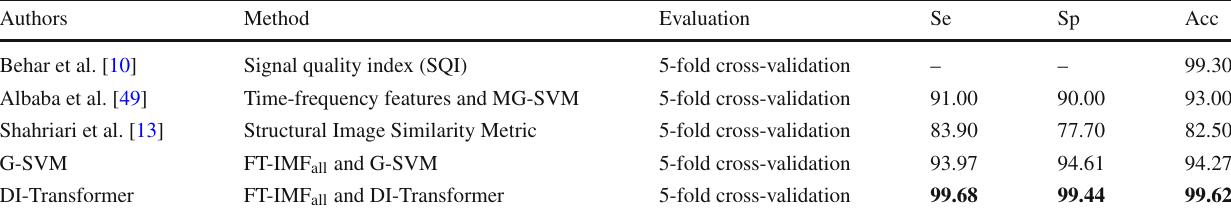
Table 14 Performance comparison with other methods Authors Method Evaluation Behar et al. [10] Signal quality index